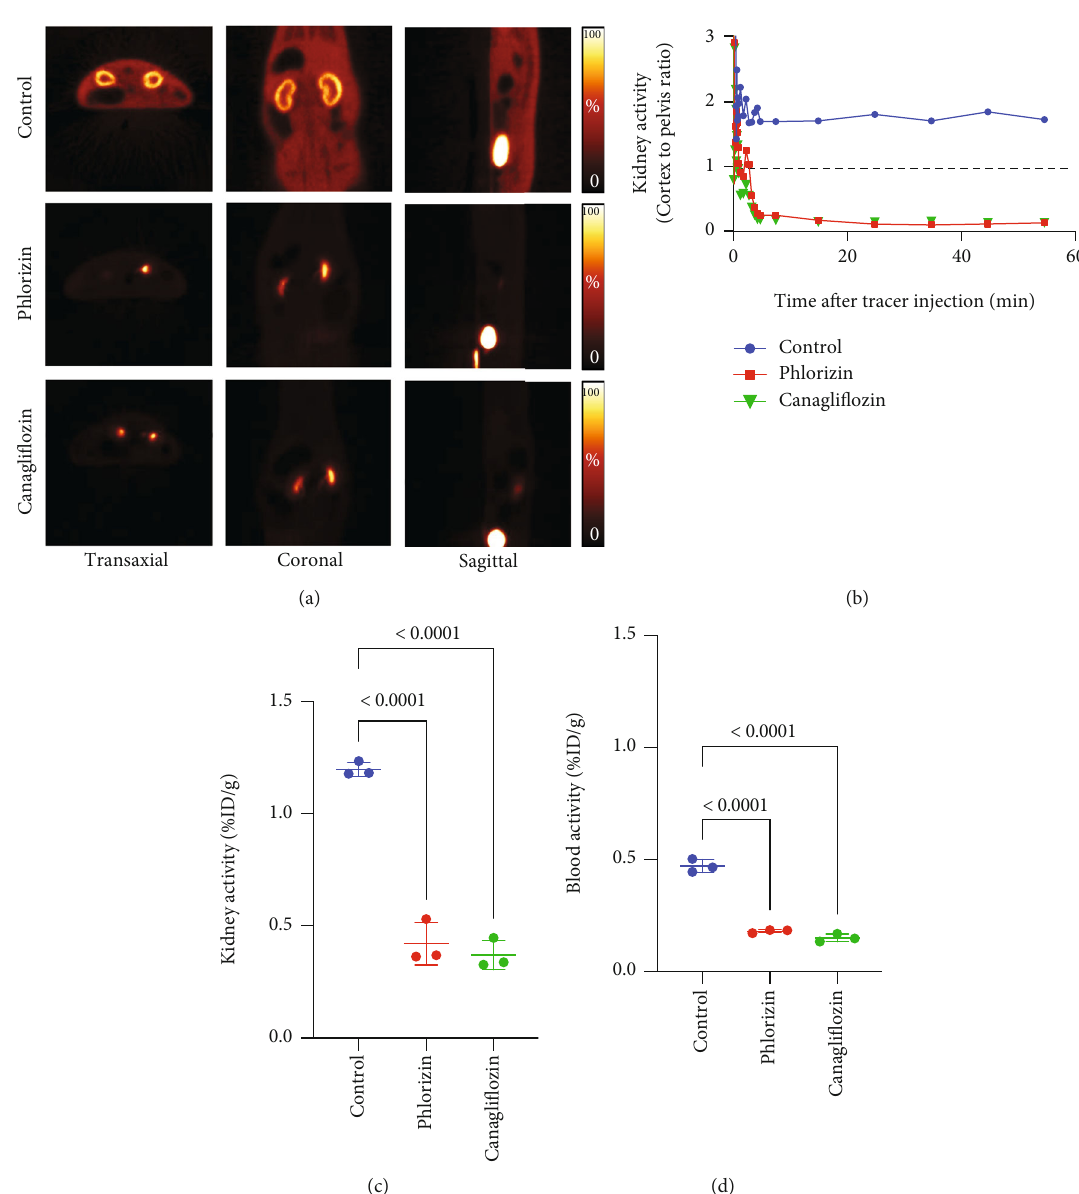
Figure 3: Results of renal [ 18 F]Me4FDG PET imaging. (a) Multidirectional PET images of an untreated control rat versus a phlorizin- and canagli fl ozin-pretreated rat 10-20 min after intravenous radiotracer administration. For controls (upper rows), renal radiotracer accumulation in the cortex was substantially increased. In phlorizin-pretreated (middle rows) and canagli fl ozin-pretreated animals (lower rows), however, renal cortical and soft tissue activity was extremely low, while radioactivity in the renal pelvis and bladder was high. (b) Time-activity curves (cortex-to-pelvis count ratios) of all investigated rats, which revealed substantially lower renal cortical activity in pretreated animals over time. Comparison of the kidney (c) and blood radioactivity (d) at 60 min after the tracer administration among all three groups. In untreated controls, but not phlorizin- and canagli fl ozin-pretreated animals, the activity in the kidney and blood was substantially increased. Bars indicate mean ± SD values. %ID: percentage of injected